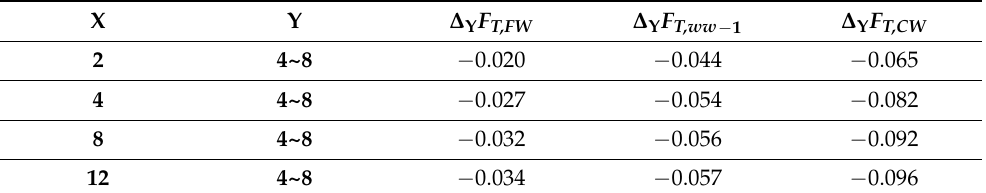
Table 2. Transfer factors changing with the changes in a room’s dimensions for X = 2~12 and Y = 4~8. (All changes are in form of decreasing with increasing